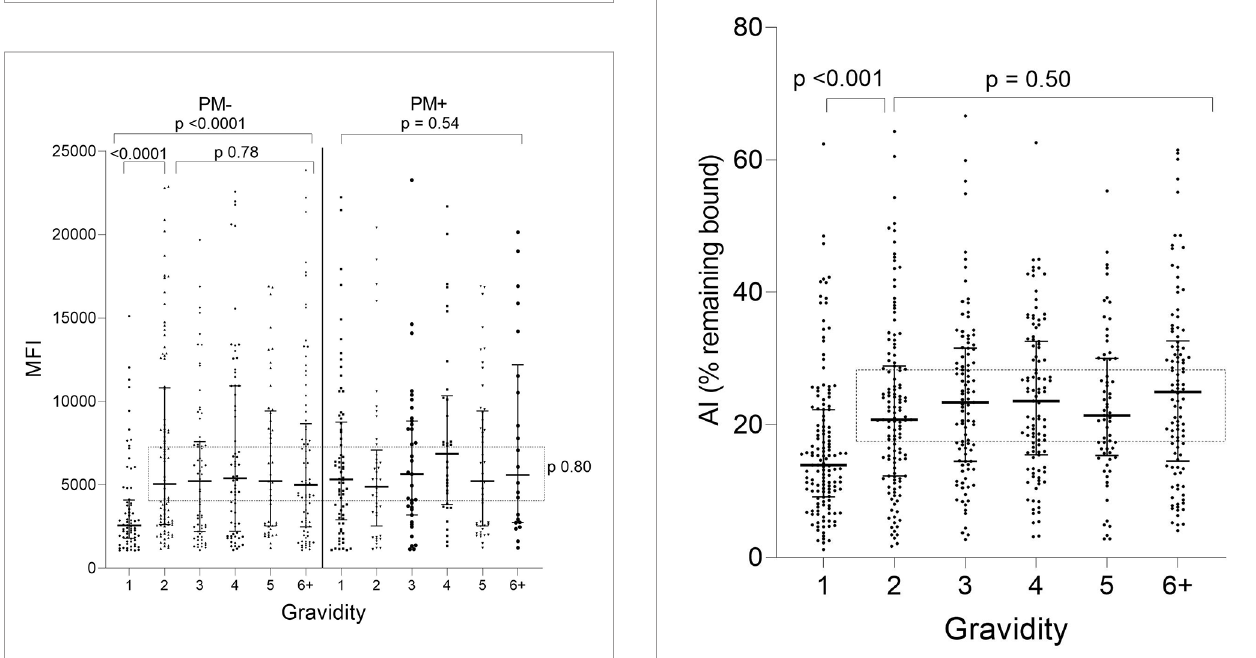
FIGURE 3 | Distribution of Ab avidity (AI) among pregnant women at delivery. AI were signi fi cantly lower in G1 than G2 ( p < 0.001), but AI did not change thereafter (rectangle: Kruskal-Wallis test: G2 through G6+ p = 0.50). Horizontal lines represent medians and IQR.